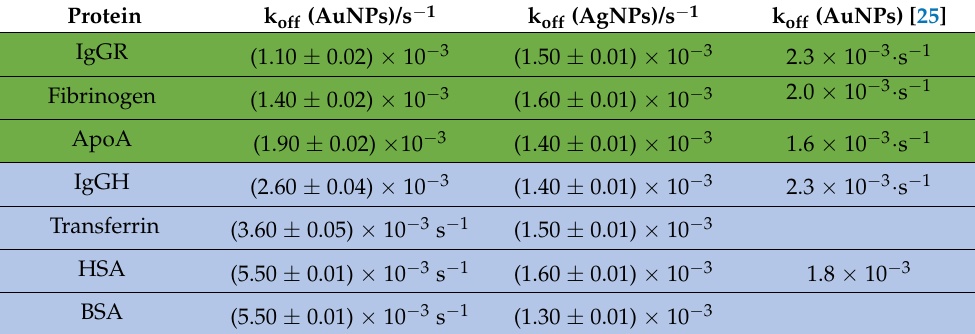
Table 1. Values of k off calculated by using the SPRi kinetics data of the interaction between AuNPs, AgNPs and proteins, and the values of K off reported in the indicated references. The color is used to differentiate the animal proteins (green) from human proteins